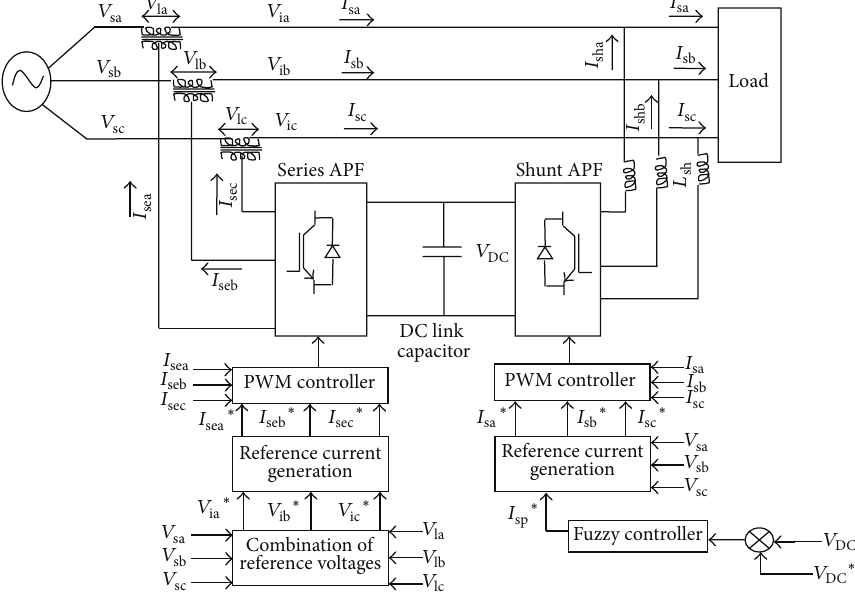
Figure 2: Control scheme of